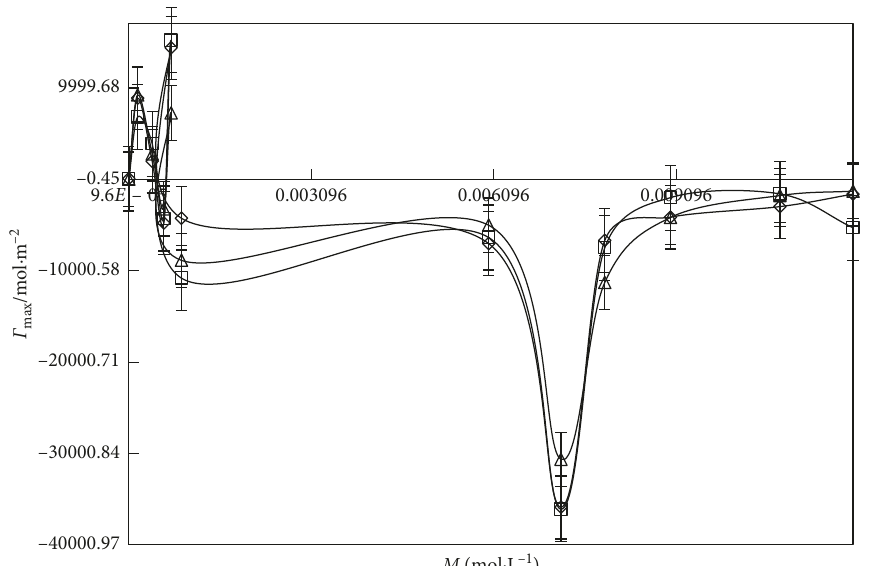
Figure 6: The Γ value of the SDS-rich surfactant at the three different temperatures T � 293.15 ( ◊ ), 298.15 ( □ ), and 303.15K ( △ ), max respectively.